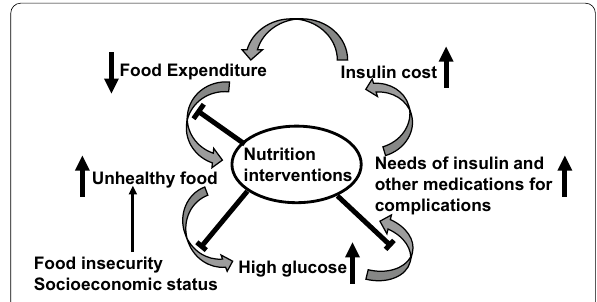
Fig. 1 A conceptual role of nutrition interventions in the improvement of insulin